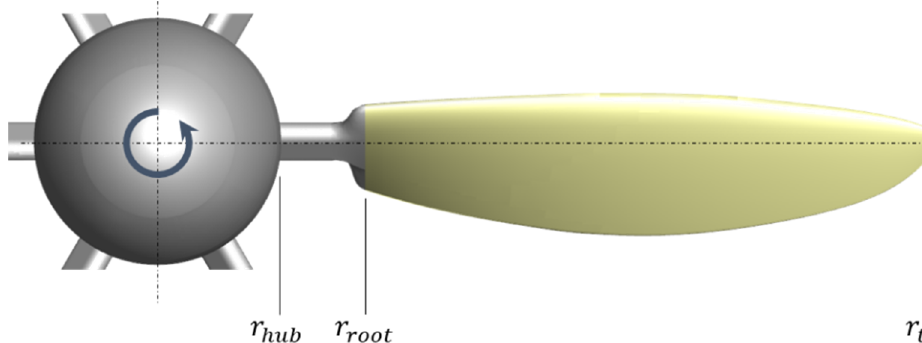
Figure 1. Propeller layout.